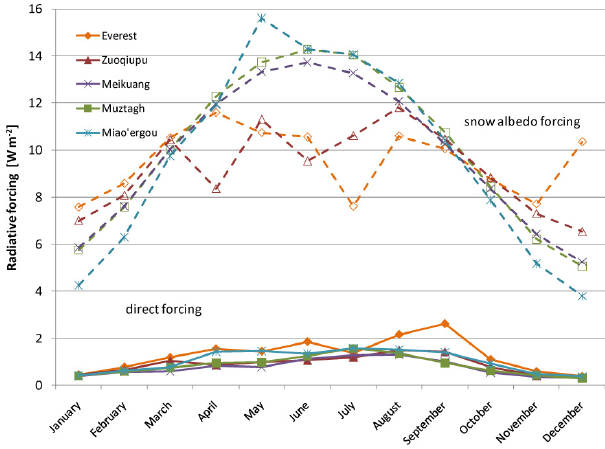
Fig. 4. Monthly mean radiative forcing due to direct (solid lines) and snow albedo effect (dashed lines) at the five glacier sites in the Himalayas and the Tibetan Plateau we analyze as recep- tors: Mt. Everest (Himalayas), Zuoqiupu glacier (southeastern Ti- betan Plateau), Meikuang (northeastern Tibetan Plateau), Mt. Muz- tagh (western Tibetan Plateau), and Miao’ergou (north of Tibetan Plateau). Direct effect forcing is a clear-sky estimate corrected for internal